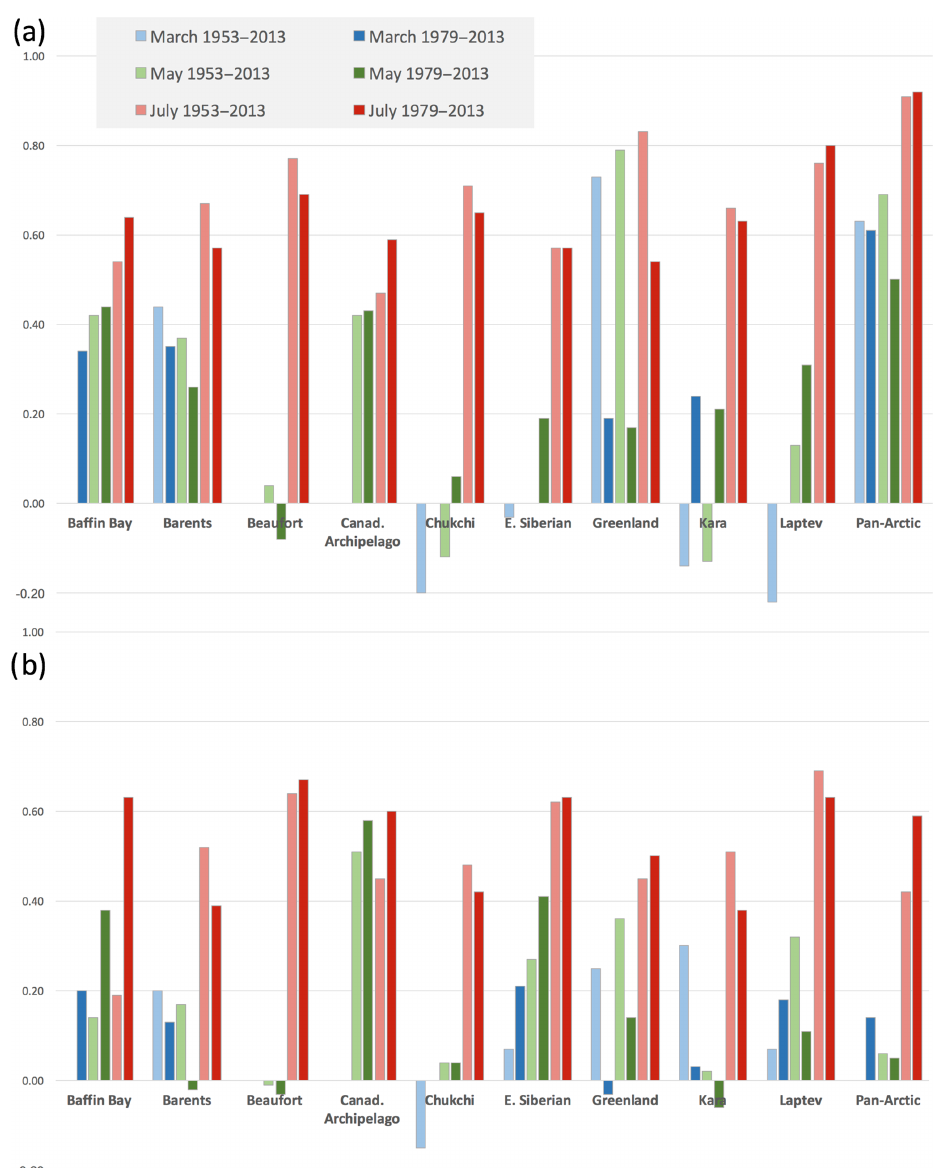
Figure 5. Correlations of September ice extents in individual seas with ice extent in the same region in March (green bars), May (blue bars), and July (red bars) bases on (a) non-detrended data and (b) detrended data. Correlations are also shown for Pan-Arctic extent (far right in each panel). The correlations are based on non-detrended data. For each color, light-colored bars are for 1953–2013 and dark-colored bars are for 1979–2013. The absence of a bar indicates a correlation of zero. The 95% significant levels for the longer and shorter samples are 0.26 and 0.33,